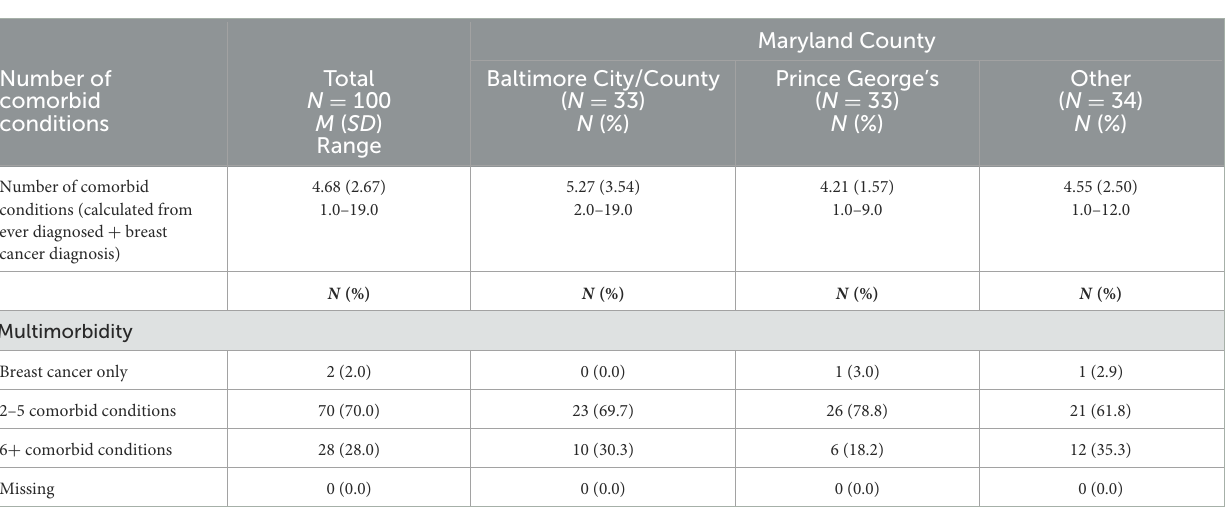
TABLE 4 Number of comorbid conditions for the study population overall and by Maryland county.